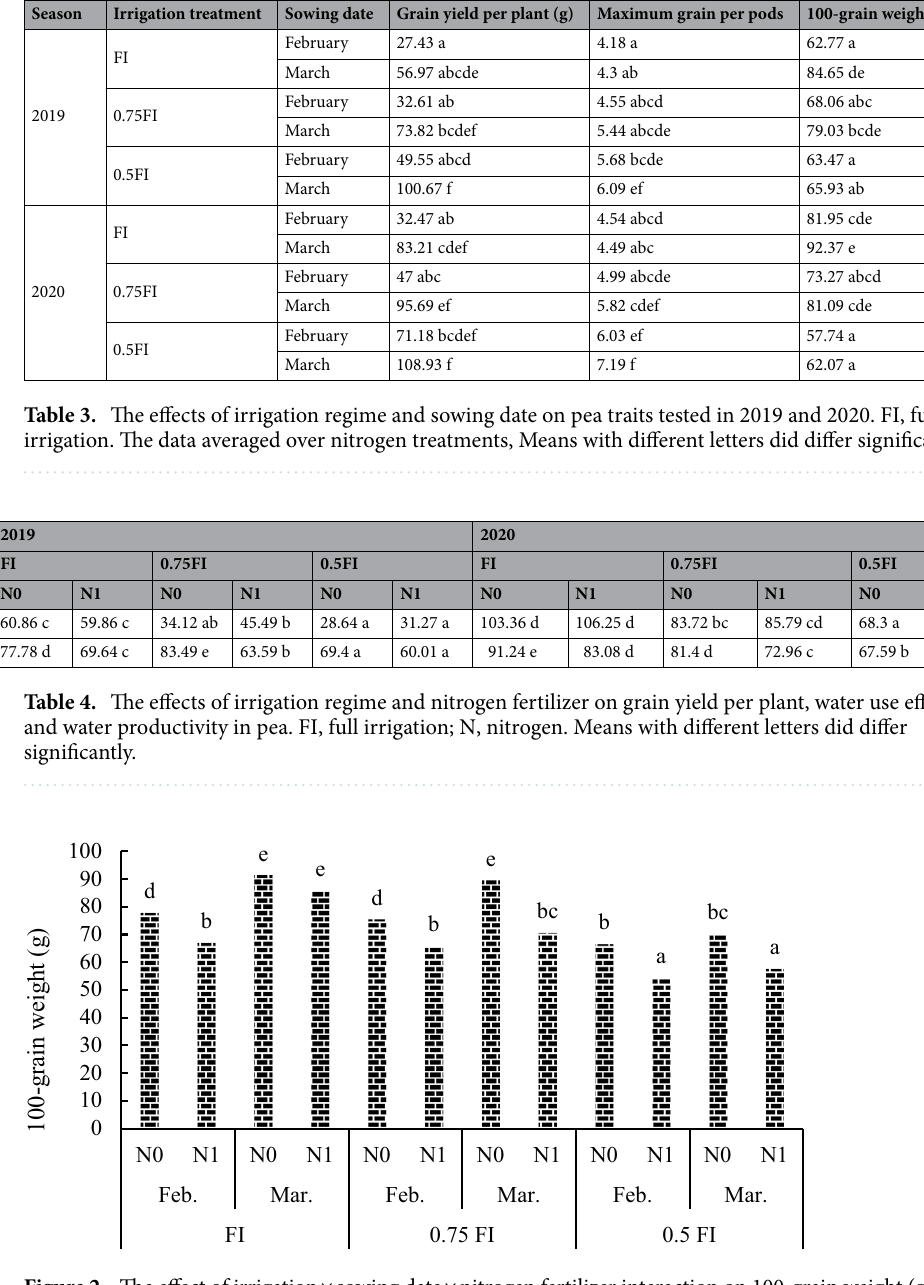
Figure 2. The effect of irrigation × sowing date × nitrogen fertilizer interaction on 100-grain weight (g) averaged over years in pea. FI: full irrigation, N: nitrogen, Feb: February, Mar: March. Means with different letters did differ